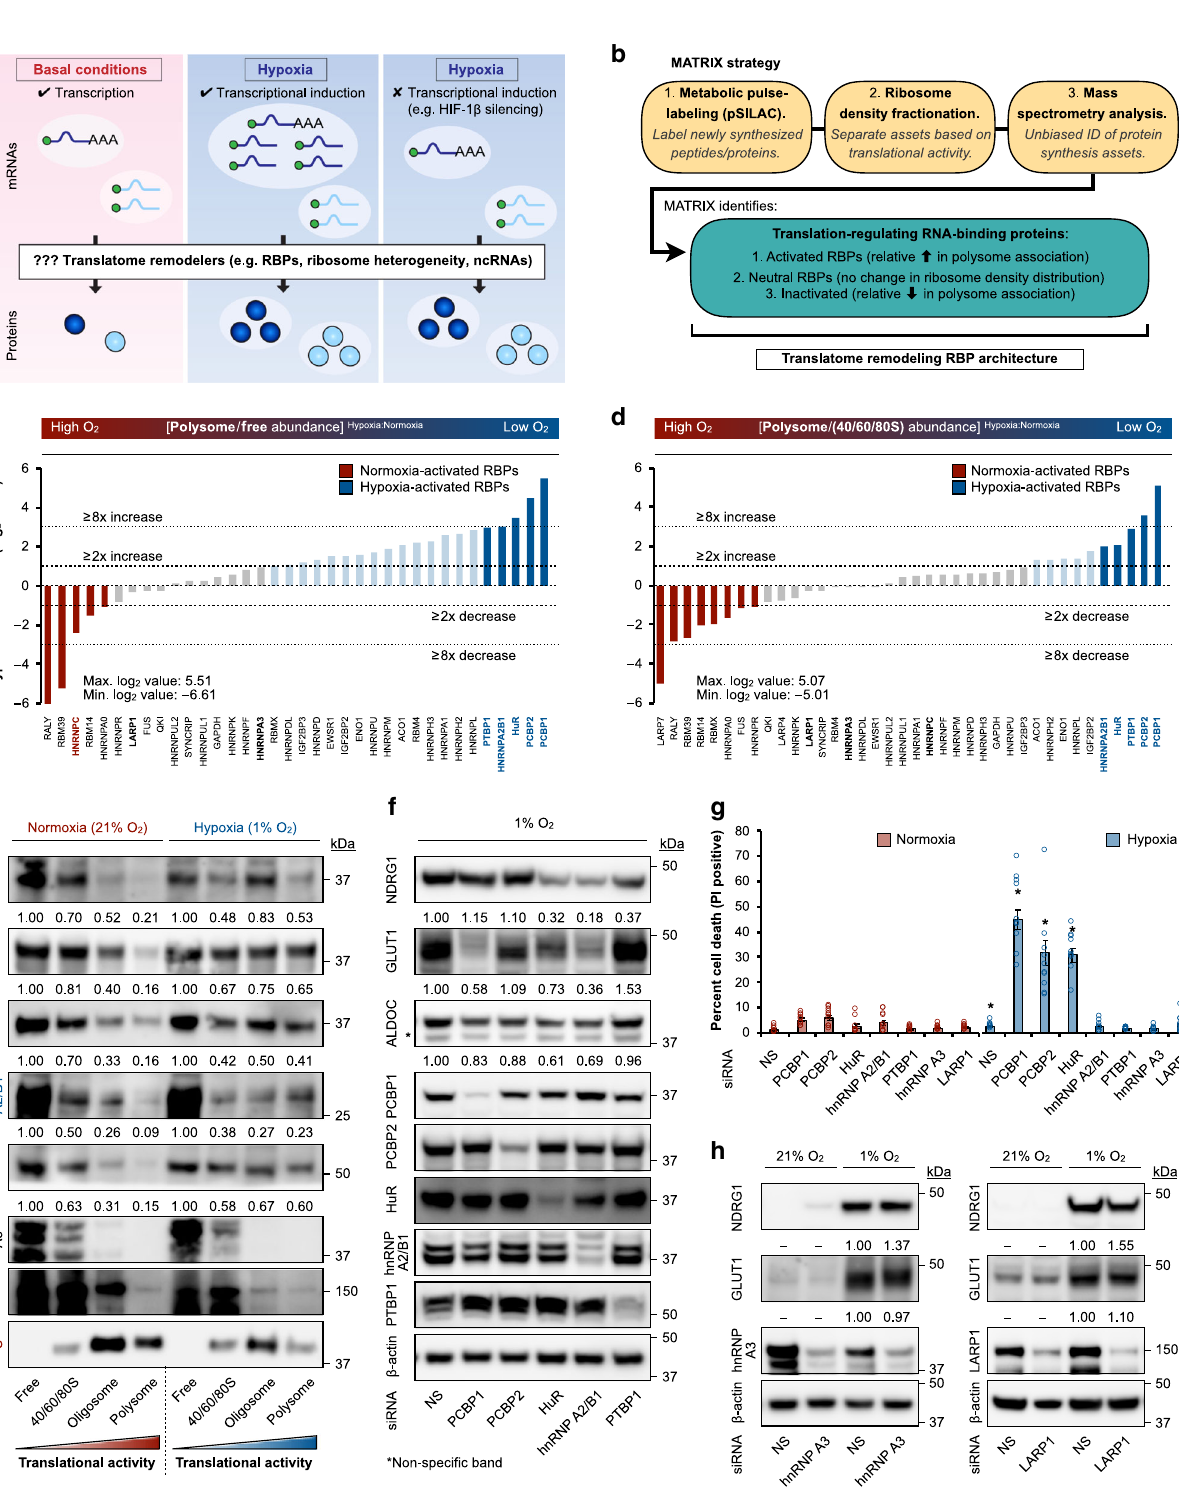
hypoxia-inducible proteins e.g. NDRG1, GLUT1, and ALDOC